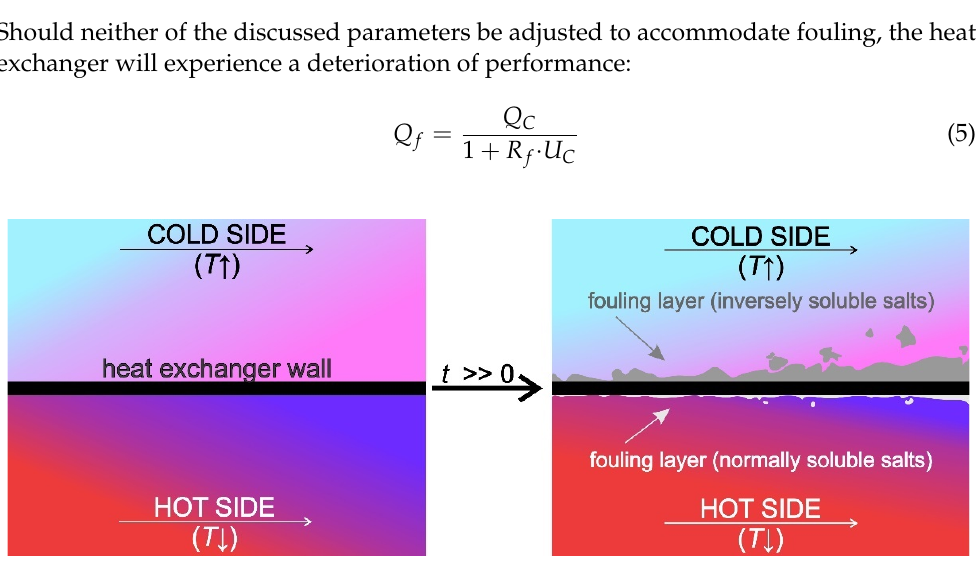
Figure 1. Schematic representation of scaling in a heat